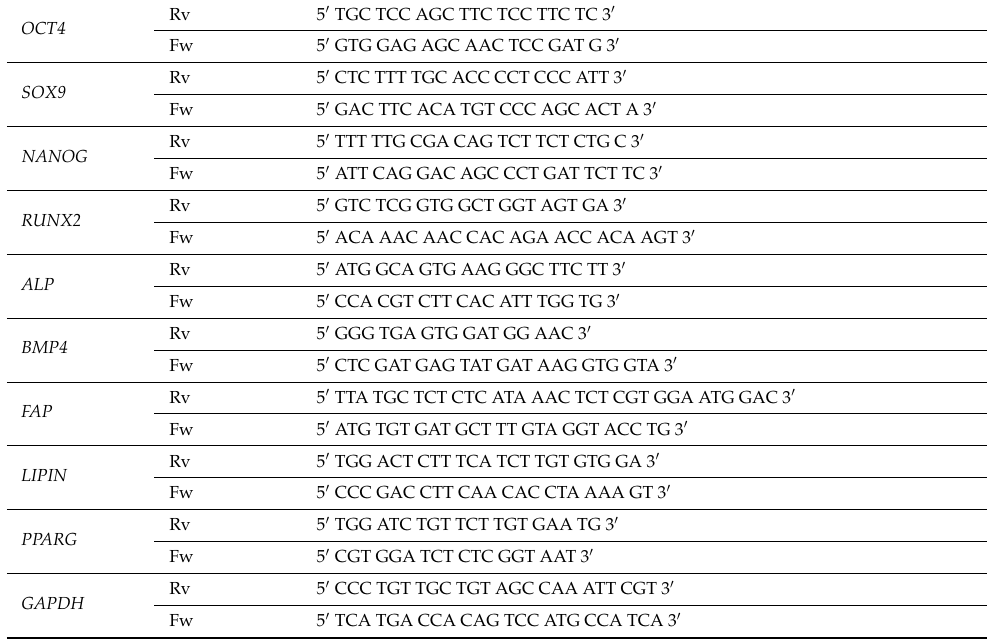
Table 1. Primers with corresponding sequences used in the